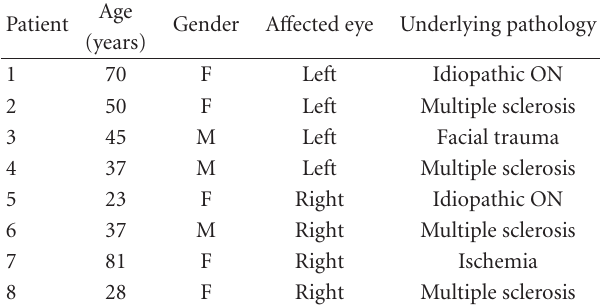
Table 1: Characteristics of the optic neuritis